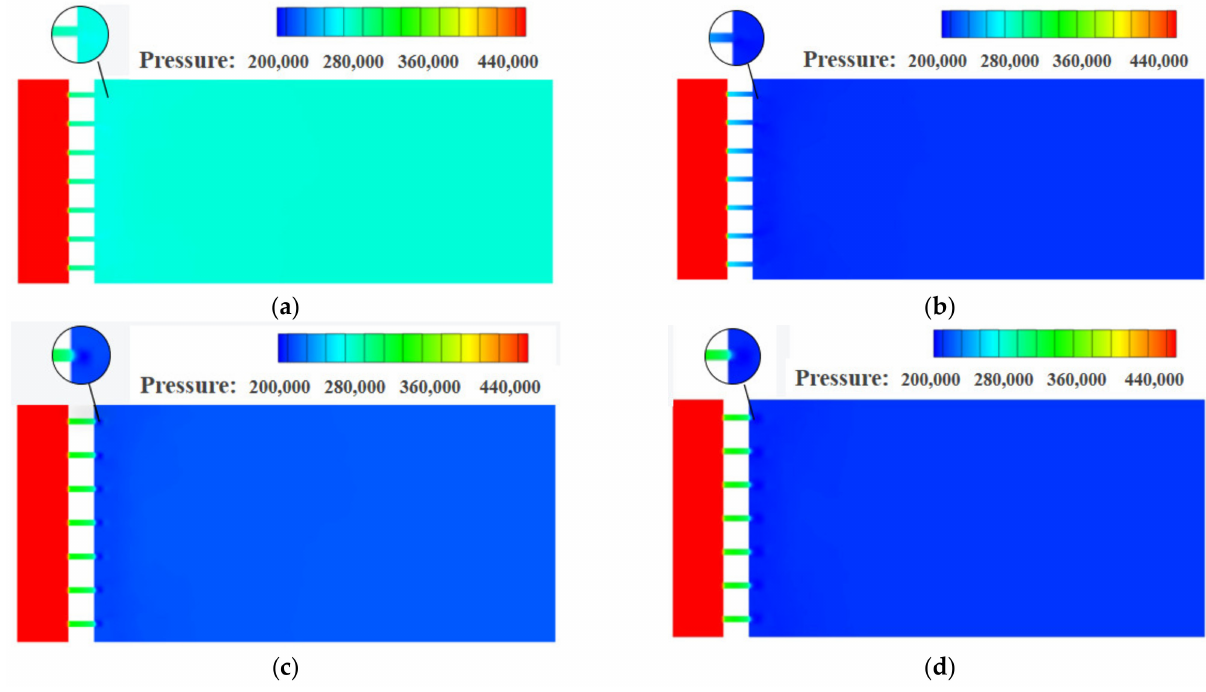
Figure 5. Pressure distribution on the symmetry plane for conventional orifice plate under different mass flow rates (pressure in Pascal). ( a ) Q m = 0.02 kg s − 1 . ( b ) Q m = 0.1 kg s − 1 . ( c ) Q m = 0.5 kg s − 1 . ( d ) Q m = 1 kg s − 1